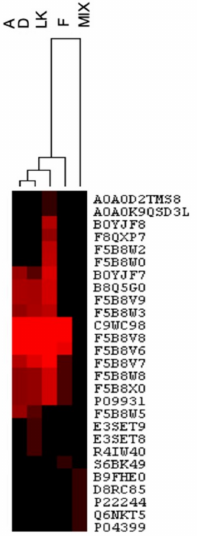
Figure 2. Hierarchical clustering analysis (HCA) with the dendrogram of the identified protein in lupin-based pasta samples and raw materials. Individual proteins are given in columns. Heat map colors are bases on values of − 10LgP (protein confidence score), combined with hierarchical clustering of